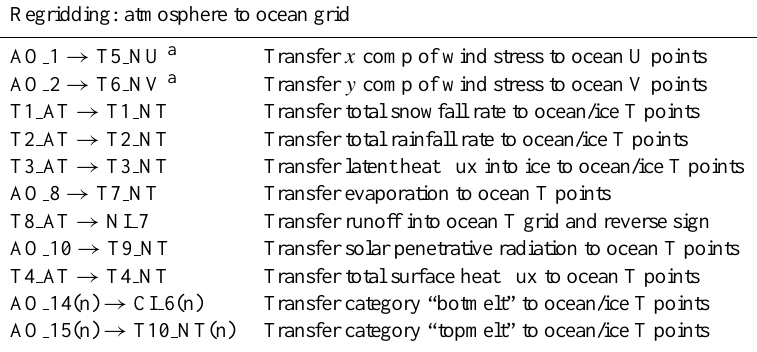
Table 1b. Details of regridding the atmosphere fields onto the ocean grid in Fig. 4. These manipulations are carried out by OASIS itself. “n” is the ice thickness category index.